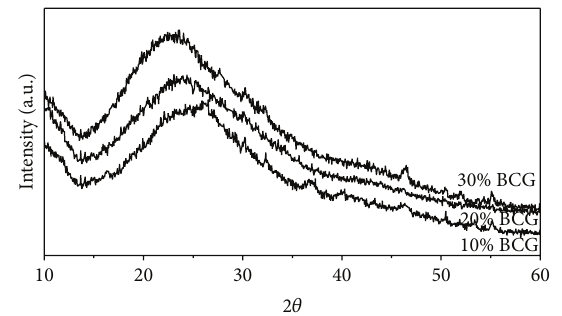
Figure 5: XRD analysis of composite scaffold with varying amount of bioglass powder.